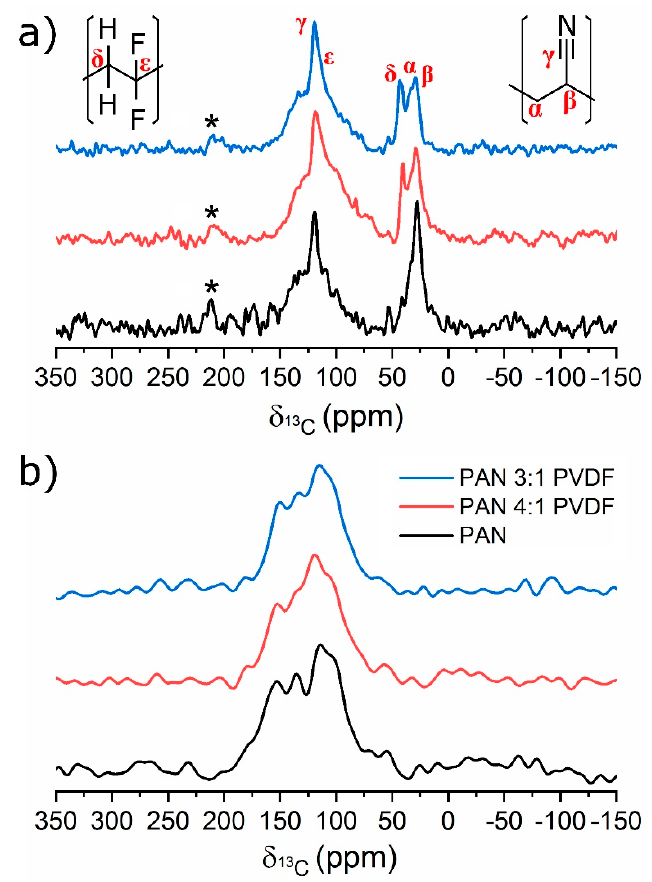
Figure 6. Solid-state 13 C spectra obtained under MAS at 7 kHz of ( a ) as-spun and ( b ) carbonized nanofibers. The peaks labeled with a star are spinning sidebands recognized by their distance of 7 kHz with respect to the γ peak. Spinning sidebands result from magic angle spinning [82].